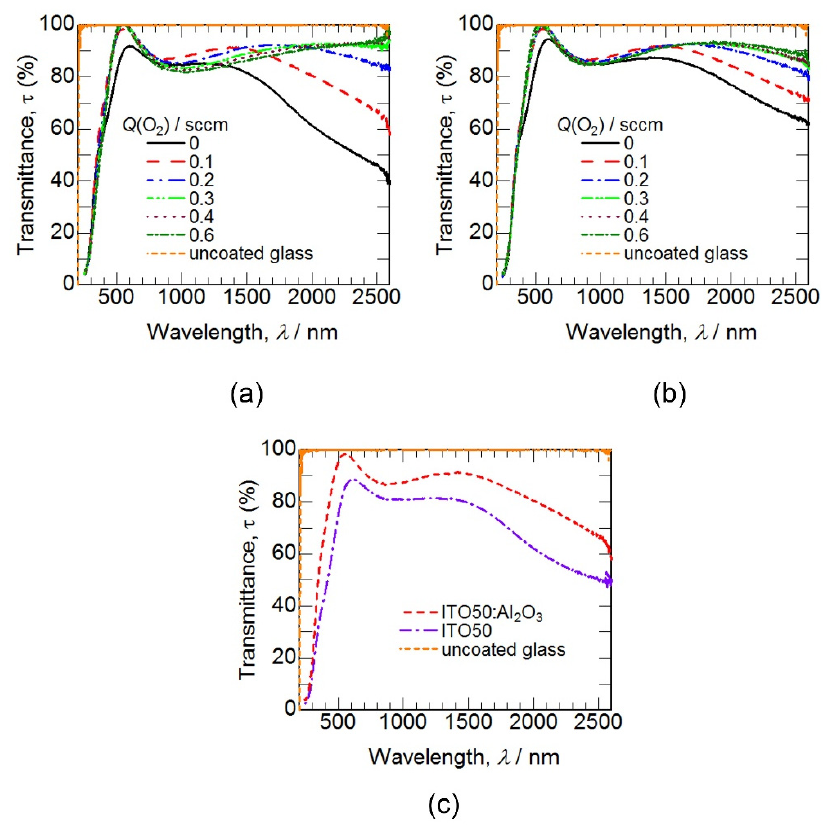
Figure 3. Effect of oxygen flow rate on transmittance of the ( a ) as-depo. and ( b ) HT523 ITO50:Al 2 O 3 (PHS) films, and ( c ) comparison of transmittance of the as-depo. ITO50:Al 2 O 3 (PHS) film and undoped ITO50 thin film sputtered at Q (O 2 ) = 0.1 sccm [12].